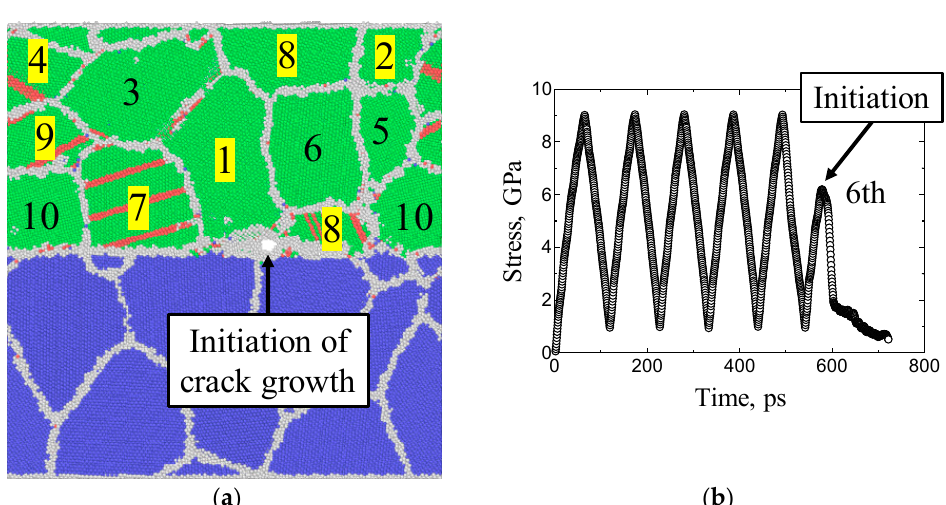
Figure 14. Snapshot at the time of fatigue crack initiation ( a ) and the transition of stress during cyclic loading ( b ) when a maximum tensile stress of 9.00 GPa was applied to Model 1.